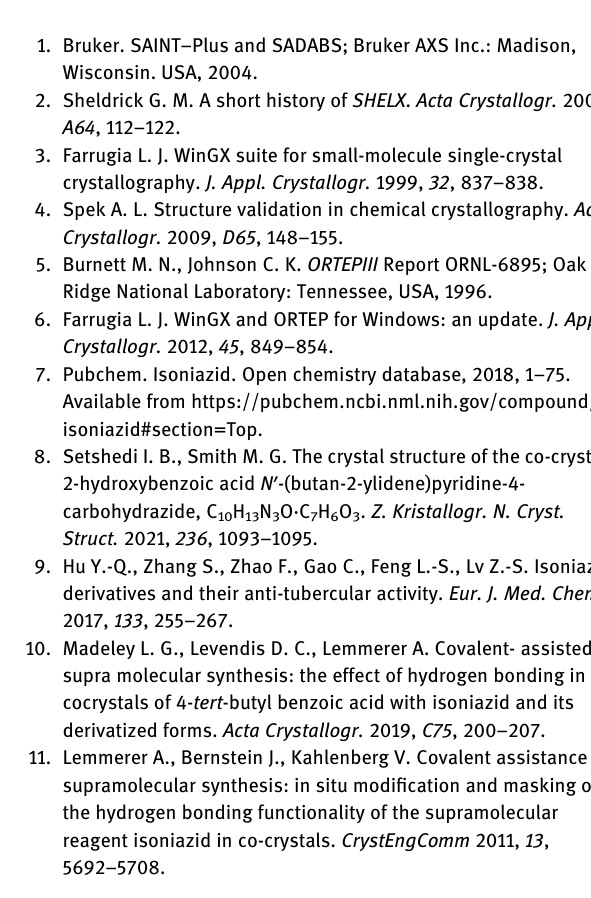
form the hemihydrate. Each carbohydrazide moiety is Table  : Fractional atomic coordinates and isotropic or equivalent